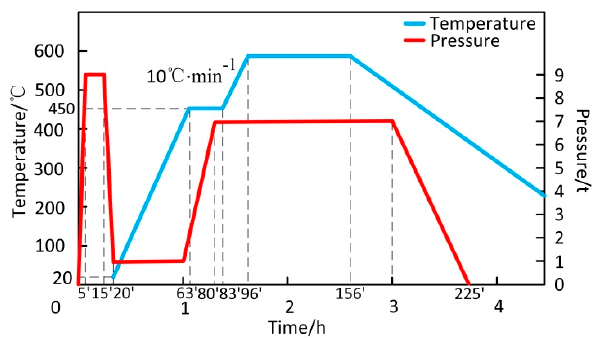
Figure 3. The preparation process and parameters in the vacuum hot pressing sintering furnace.